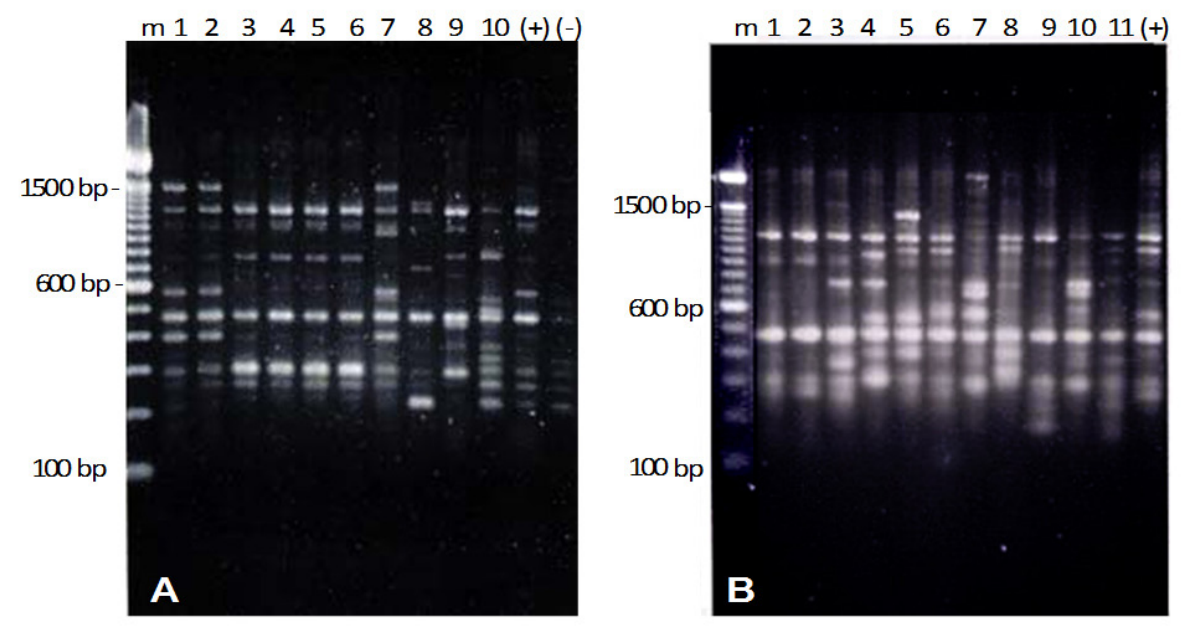
Figure 2. Coexistence of several different clones of Pseudomonas aeruginosa in pediatric ( A ) and medical- surgical ( B ) intensive care units. ( A ) Lanes 1 and 2: patient CAS, clone N5; lanes 3 to 6: GMS (N6); lane 7: IGN